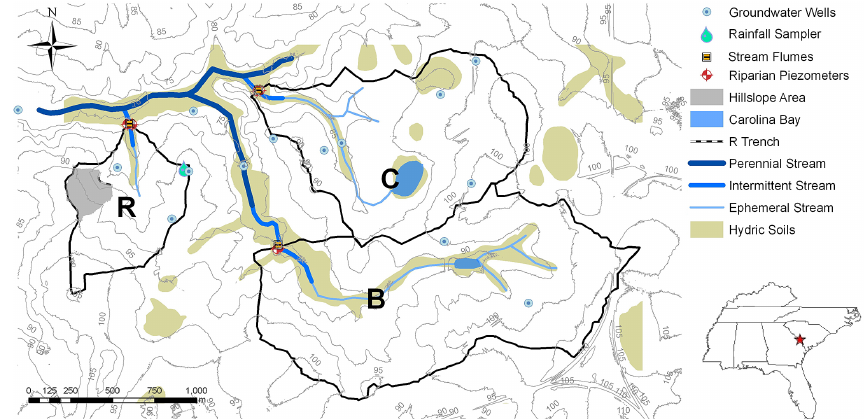
Figure 1. Study site with the three watersheds (R, B, C), the trenched hillslope, streams, instrumentation, the distribution of hydric soils, and the location within the US.